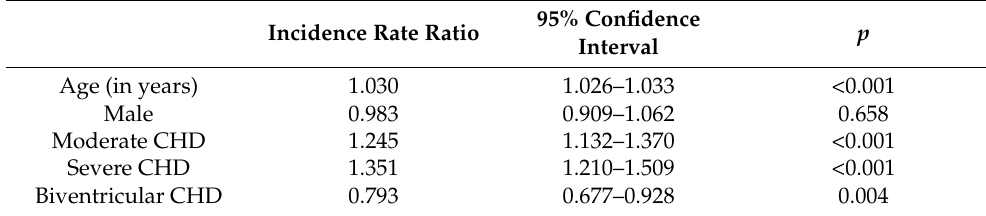
Table 4. Association between age, complexity of CHD, and gender with number of comorbidities. 95% Confidence p Incidence Rate Ratio Interval Age (in years)